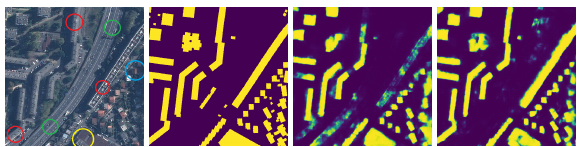
Figure 5. Advantage of stereo training for DispNetC network over an image of Toulouse (1). From left to right : image, ground truth, monocular prediction and stereo prediction